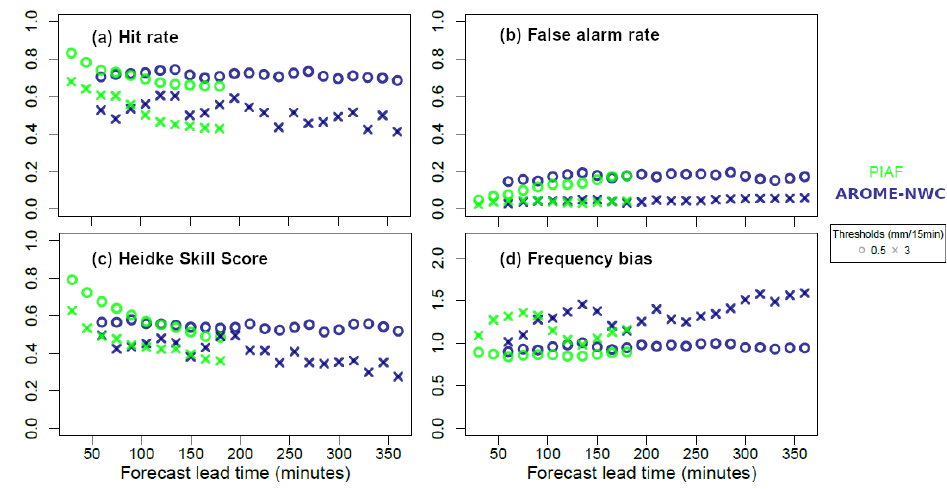
Figure 10. (a) Hit rate, (b) false alarm rate, (c) Heidke skill score, and (d) frequency bias for thresholds: 0.5mm/15min and 3mm/15min computed for AROME-NWC (in blue) and PIAF (in green) over their respective forecast ranges for 15min rain accumulation forecasts averaged over the catchments.